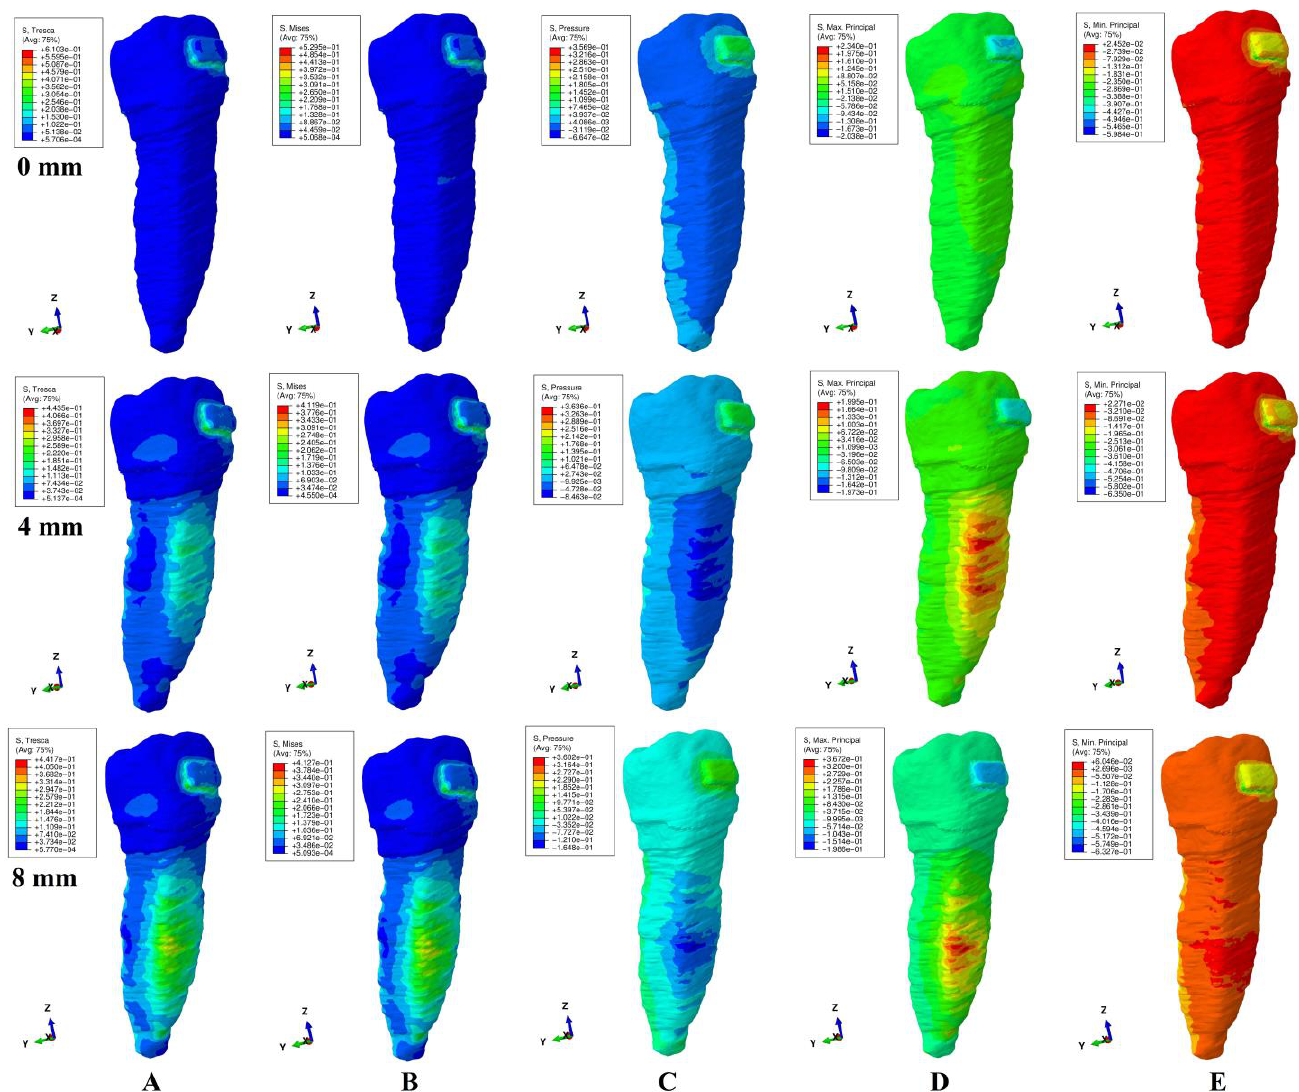
Figure 6. Comparative stress display of the five failure criteria in intact, 4 mm and 8 mm periodontal breakdown for the tipping movement under 0.5 N of load: ( A ) Tresca; ( B ) Von Mises; ( C ) Pressure; ( D ) S1; ( E ) S3.